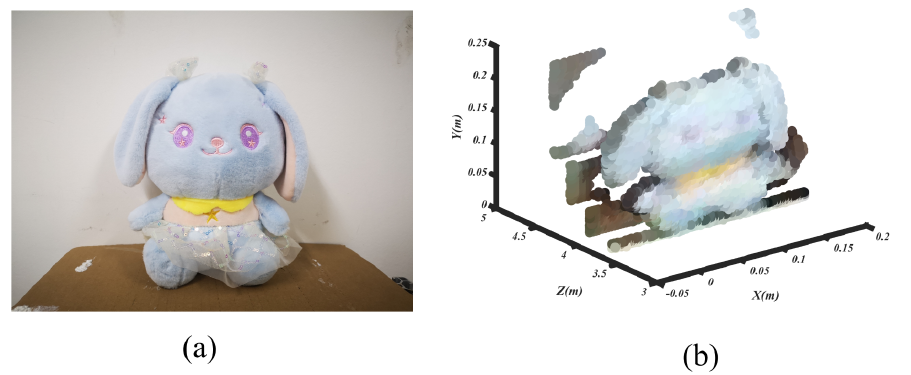
Figure 13. 3D imaging experiment of doll. ( a ) Experiment scene. ( b ) Colorized point cloud of